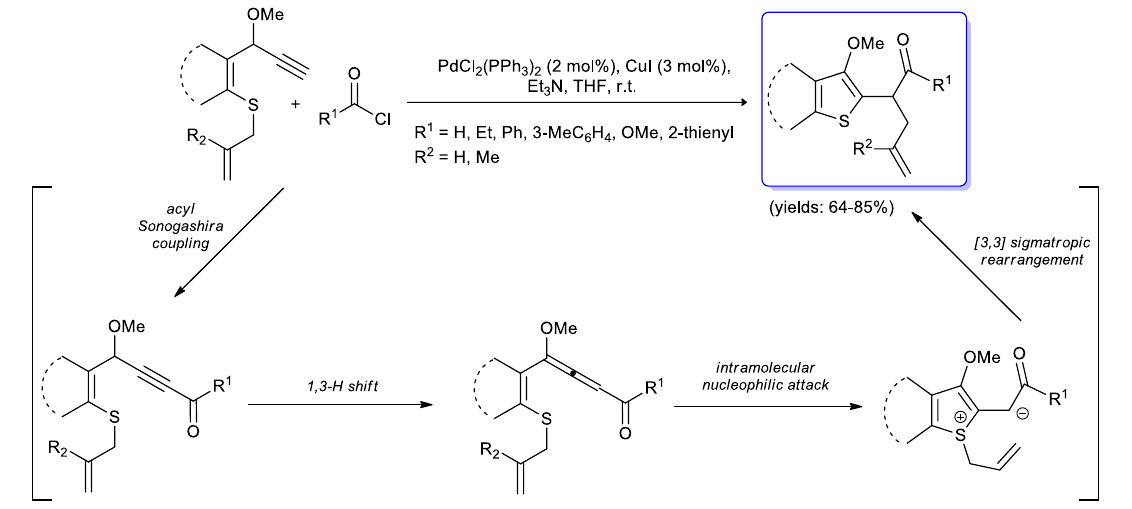
Figure 9. Polycyclic π-conjugated oligomers containing benzene or thiophene as the central core synthesized by Müller and